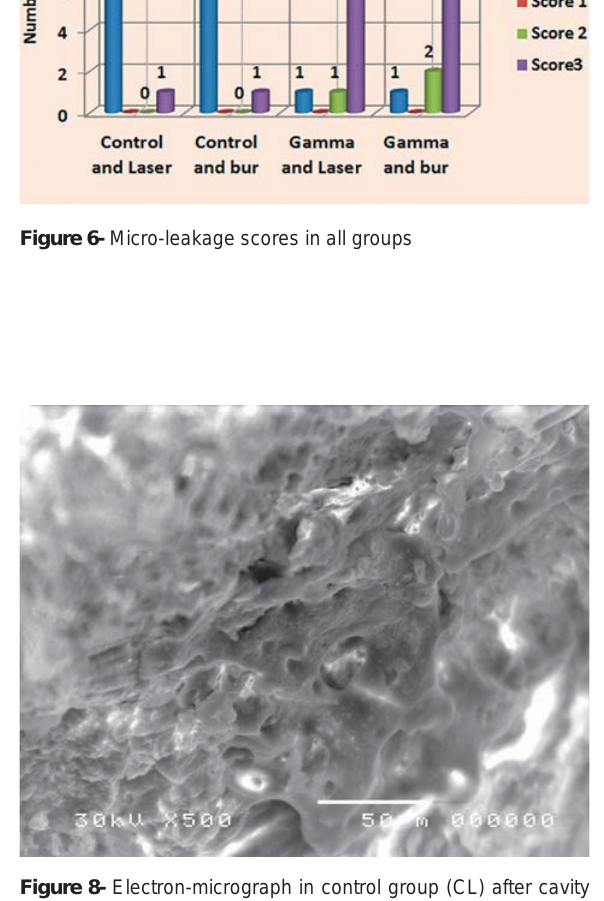
Figure 7- Electron-micrograph in control (CL) group after cavity preparation with laser revealing a rough irregular surface. The smear layer was removed and the surface structure is maintained (x2,000)